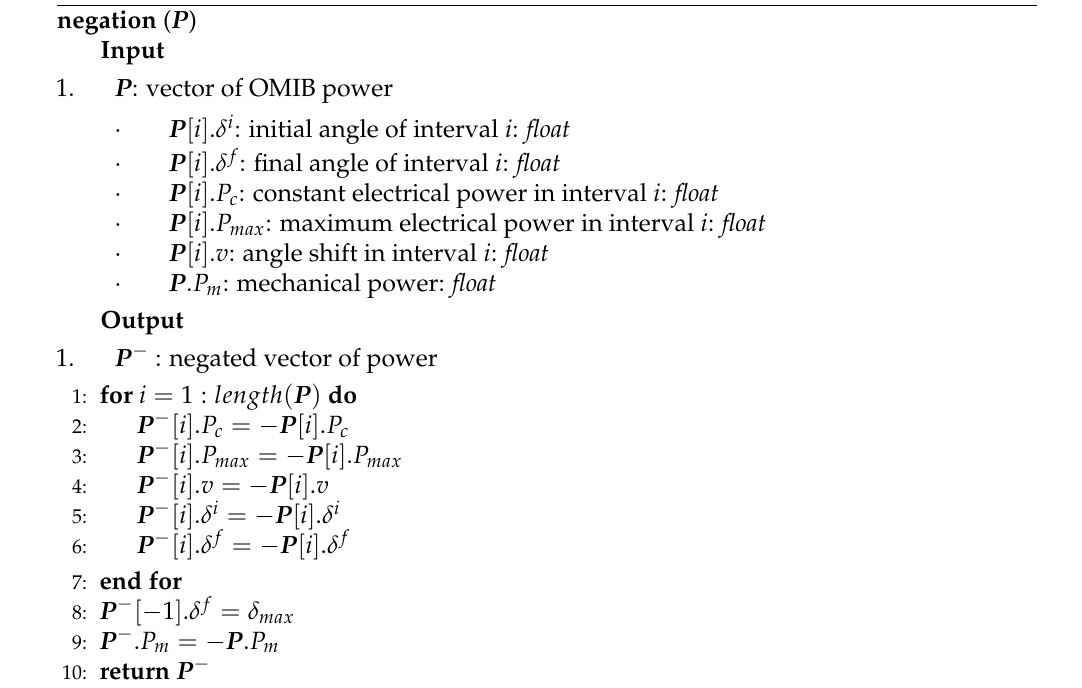
Algorithm A5 Returning the negated values of power vector